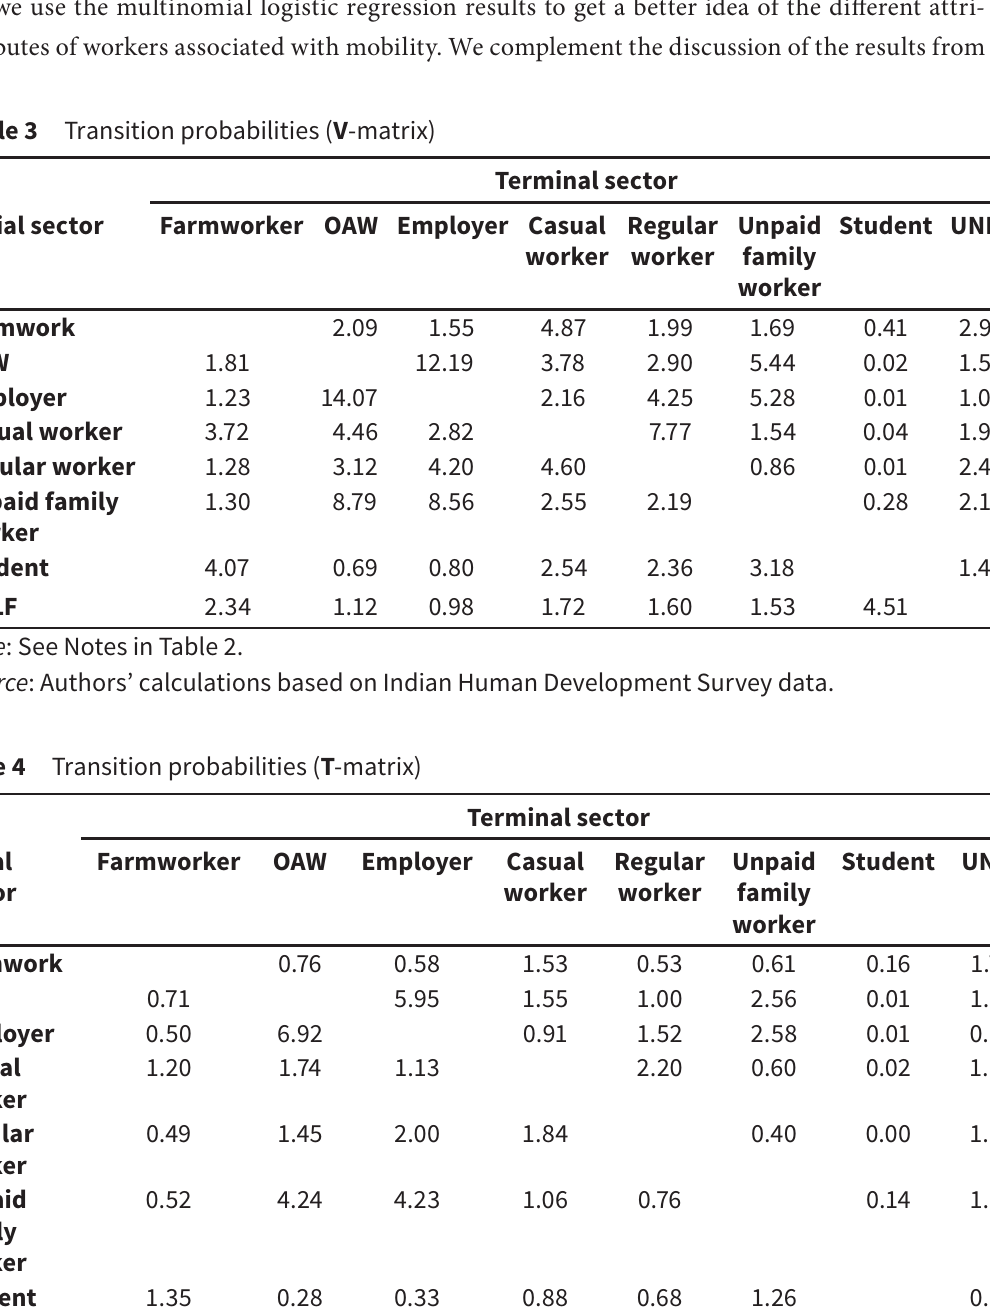
Transition probabilities ( V -matrix) Initial